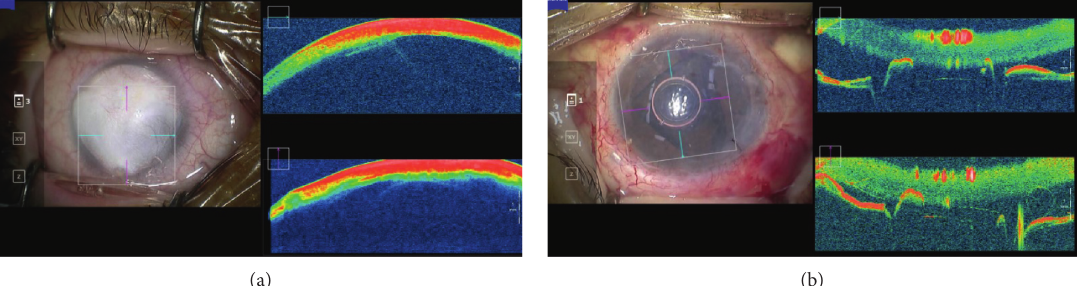
Figure 6: Limitations of MIOCTfor corneal surgery. (a) MIOCTimage of high-intensity congenital corneal opacity at the beginning of the surgery. Although the iris adhesions to the endothelial side of the cornea can be discerned, further detailed observation is not possible. (b) MIOCT image of DMEK case. An inverted ghost image of the cornea obscures the edge of the DMEK graft.